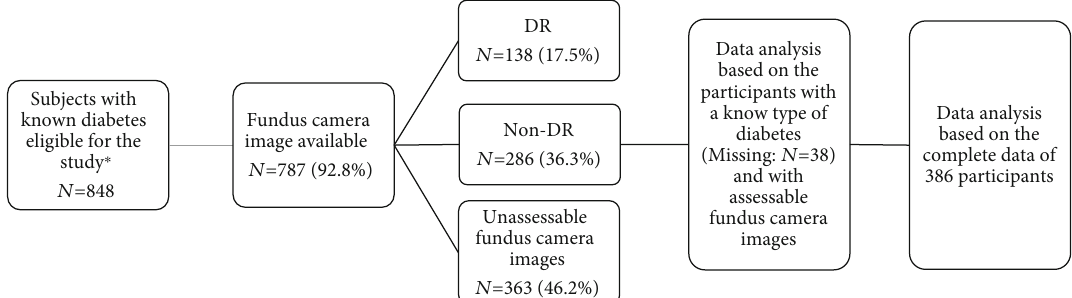
Figure 1: Flowchart of the study sample. DR: diabetic retinopathy; Non-DR: nondiabetic retinopathy; N: number. ∗ Ful fi lled the self- completed questionnaire and had a fundus camera image taken.